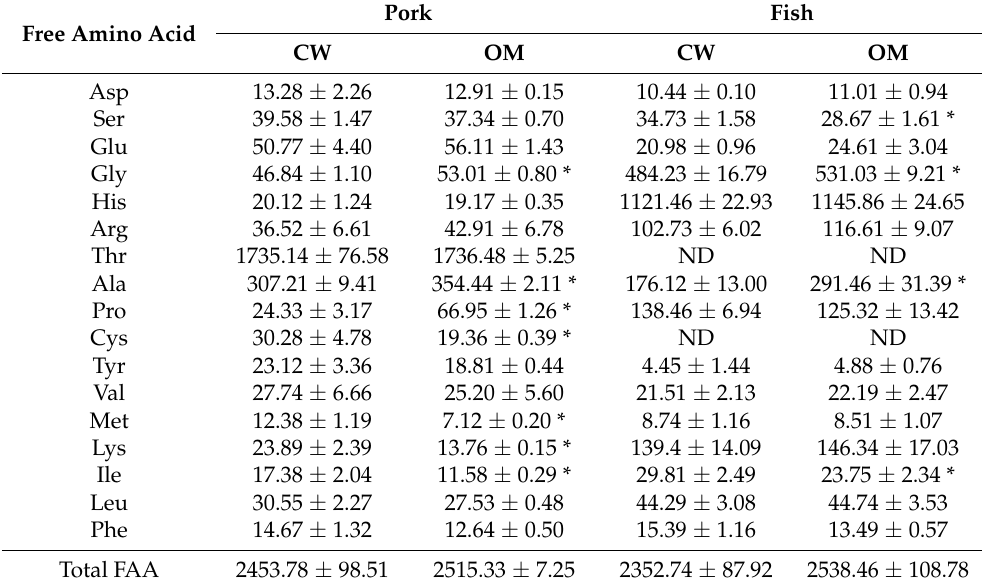
Table 3. Free amino acid composition ( µ g/g) in pork and fish samples under conventional water- washing (CW) treatment and ozone-microbubble-washing (OM) treatment. Free Amino Acid